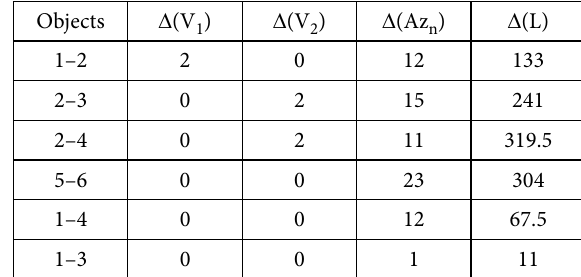
Table 2. Calculated parameters for candidates